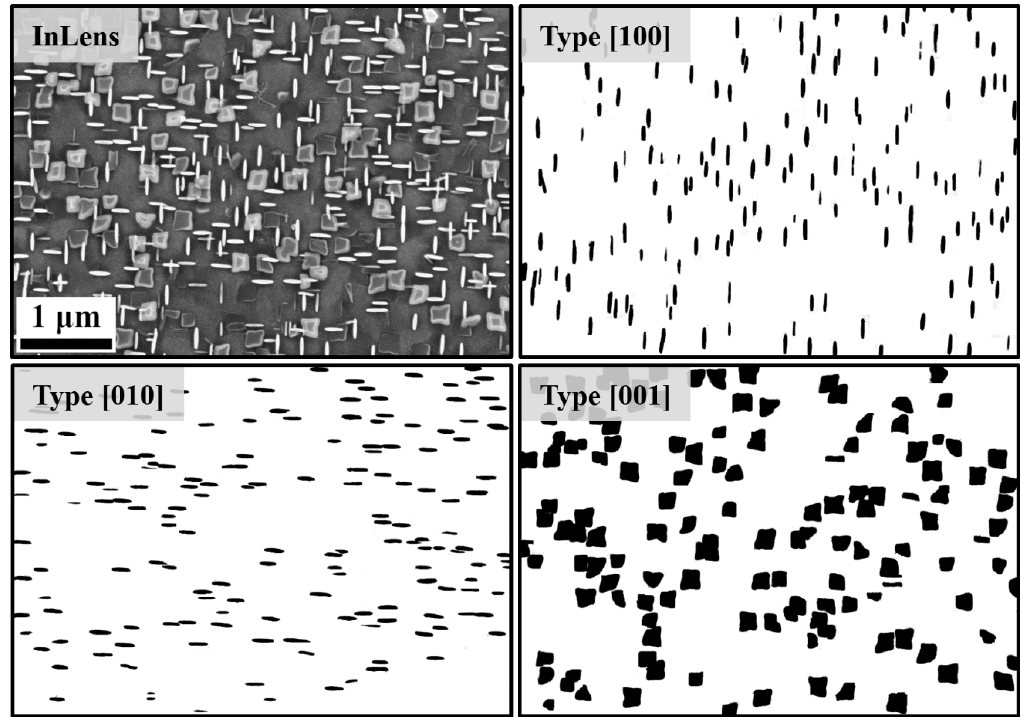
Figure 10. Binarization of the γ′′ particles from a sample after aging at 730 °C for 10 h with regard to three different crystallographic directions.